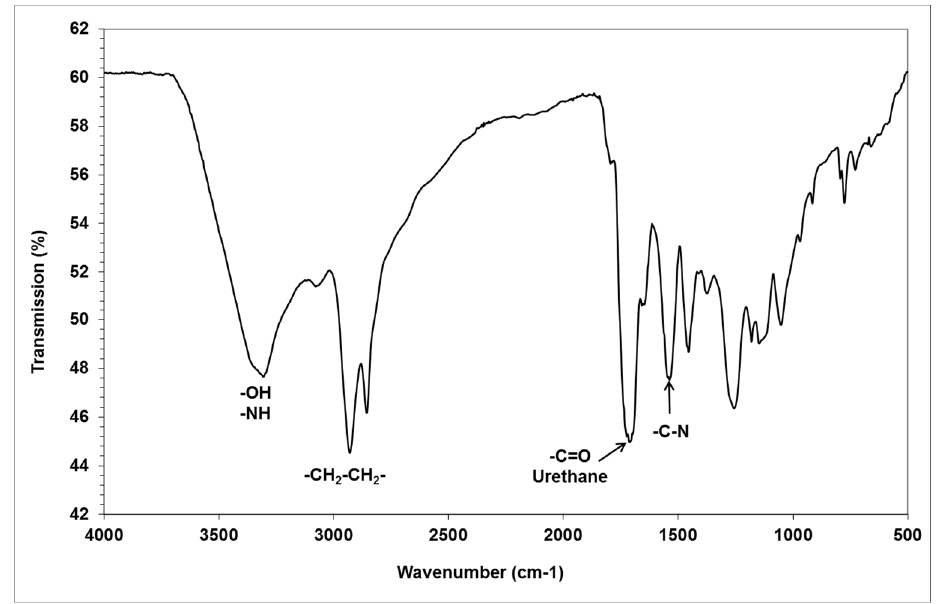
Figure 5. Infrared spectrum of a glycerol amino ethylene ester PHU resin (trial 9).